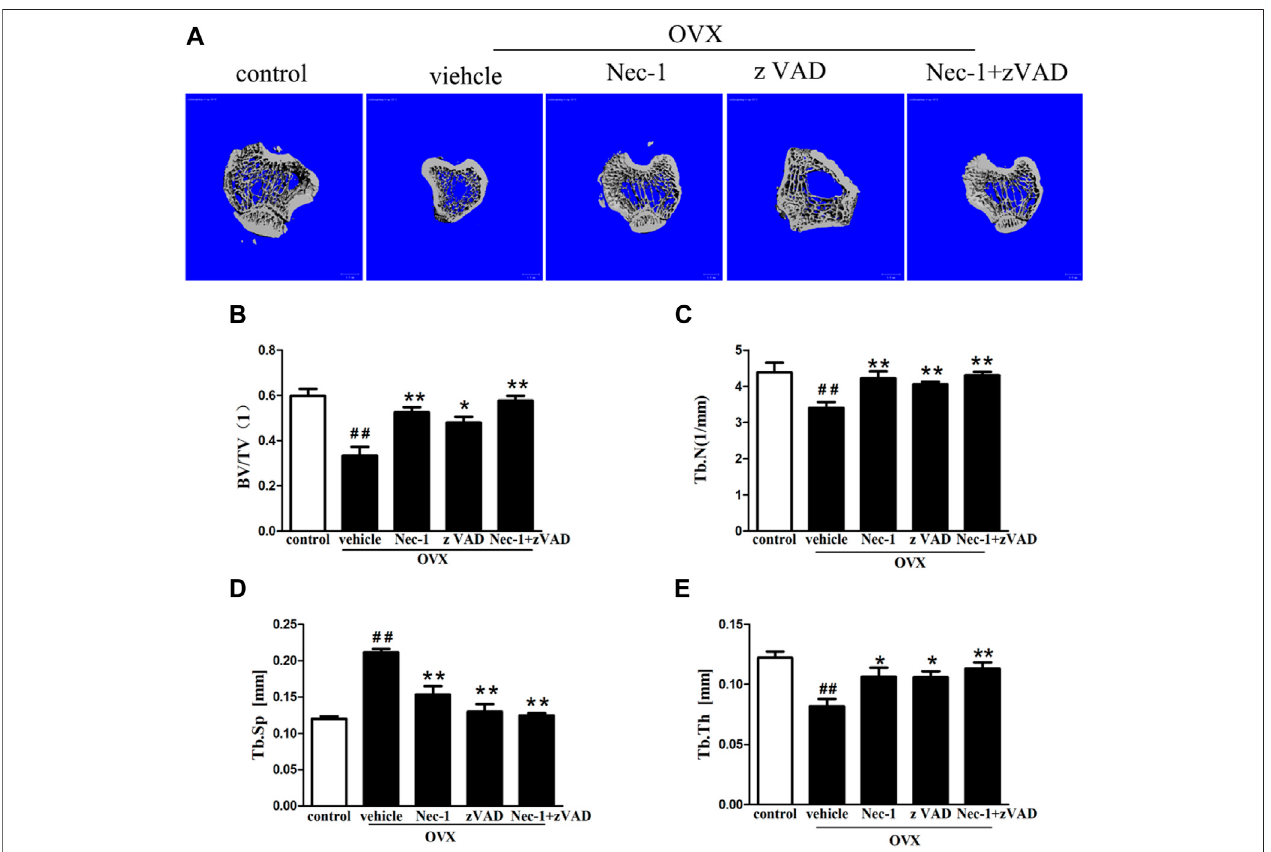
FIGURE 1 | Bone loss was measured by micro-CT in OVX rats. The bone matrix of the tibial plateau was scanned using micro-CT, and the microarchitectural parameters (BV/TV, Tb.Th, Tb.Sp, and Tb.N) were calculated automatically. (A) Representative 2D reconstructed images were obtained in each group (scale bar